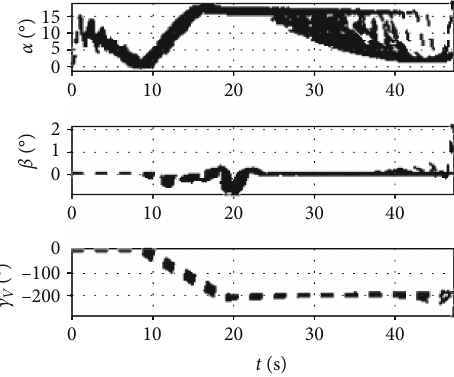
Figure 25: Curves representing the attack, sideslip, and bank angles.